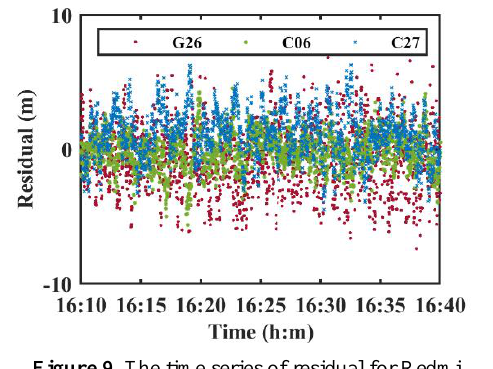
Figure 9. The time series of residual for Redmi.